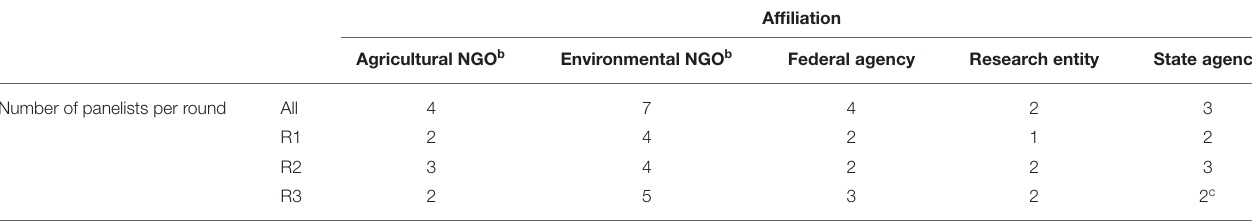
TABLE 2 | Affiliations represented and number of participants per round in the Delphi survey a .